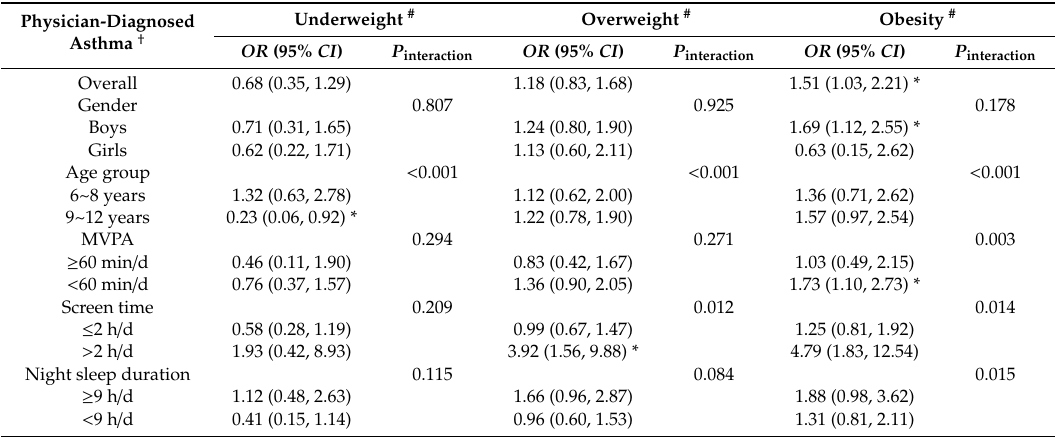
Table 3. Analysis of the association between physician-diagnosed asthma and weight status stratified by gender, age, and lifestyle factors.